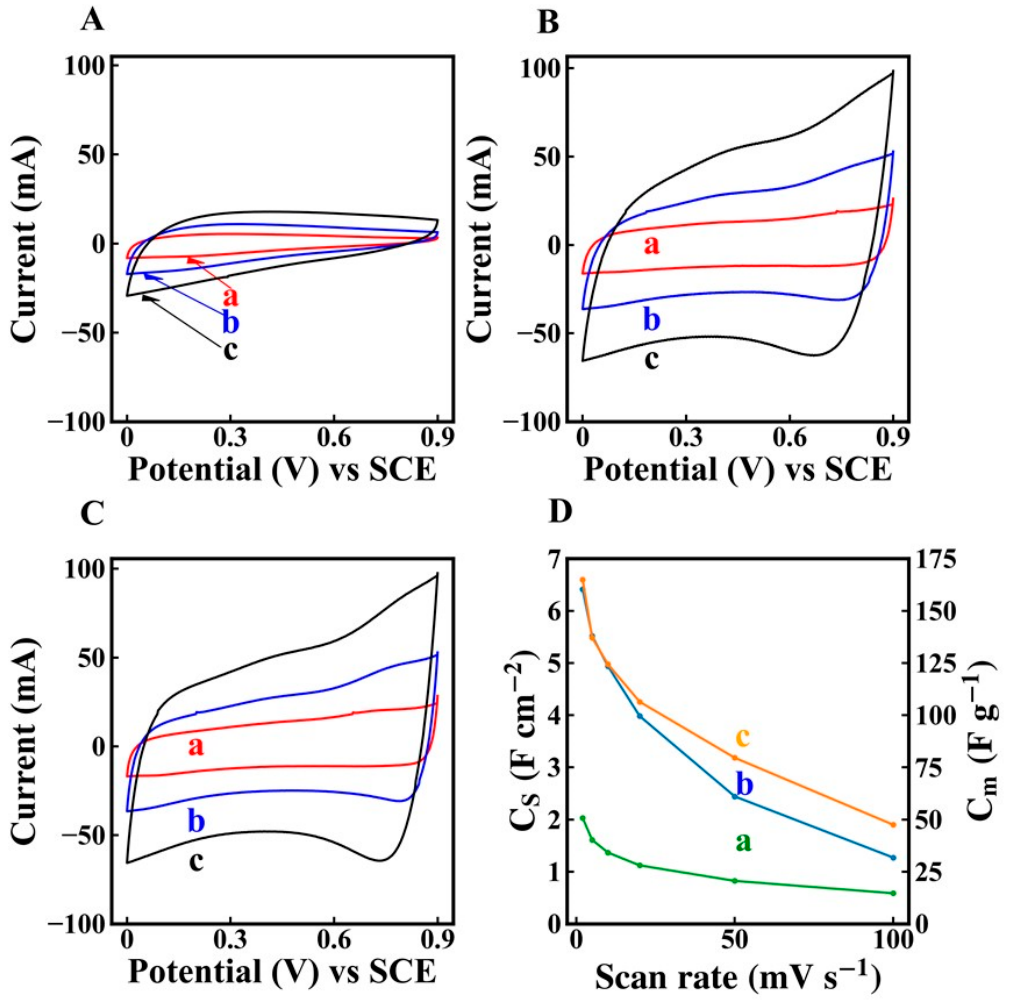
Figure 5. ( A – C ) CVs at scan rates of (a) 2, (b) 5 and (c) 10 mV s − 1 for electrodes prepared ( A ) without dispersant, ( B ) in the presence of chlorogenic and ( C ) in the presence of 3,4,5-trihydroxybenzamide, ( D ) Cs and Cm versus scan rate for